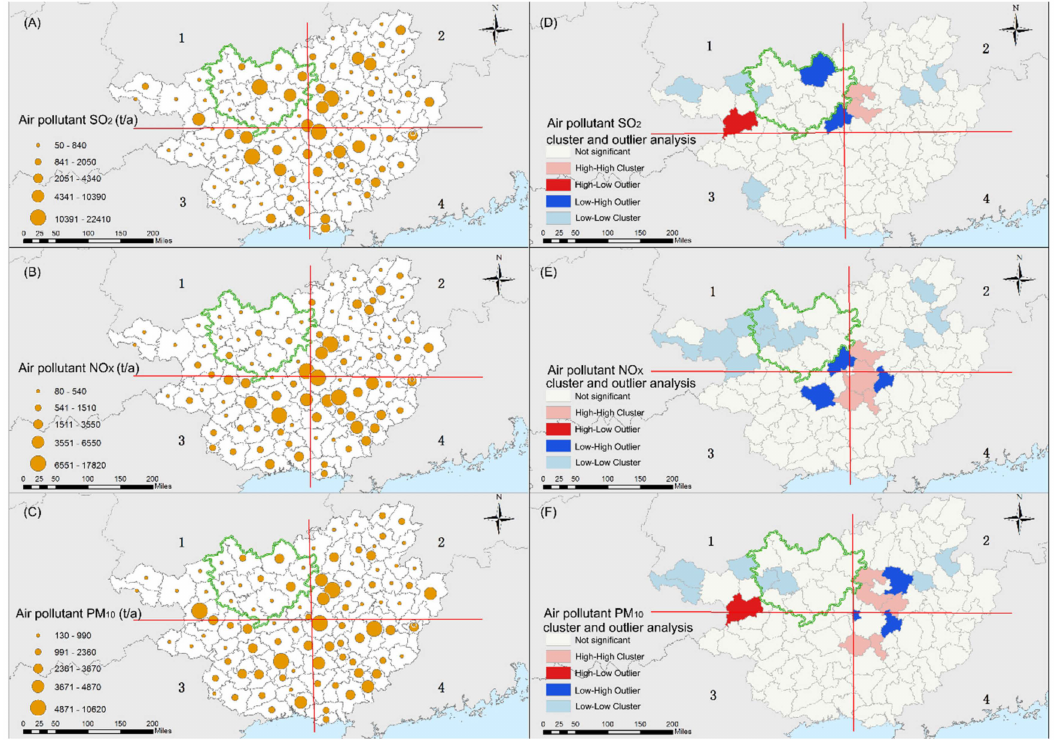
Figure 2. Spatial distribution of the three air pollutants ( A – C ) and the results ( D – F ) of the cluster and outlier